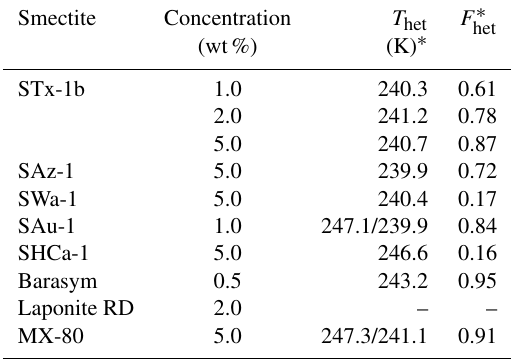
Table 4. Ice nucleation ability of investigated